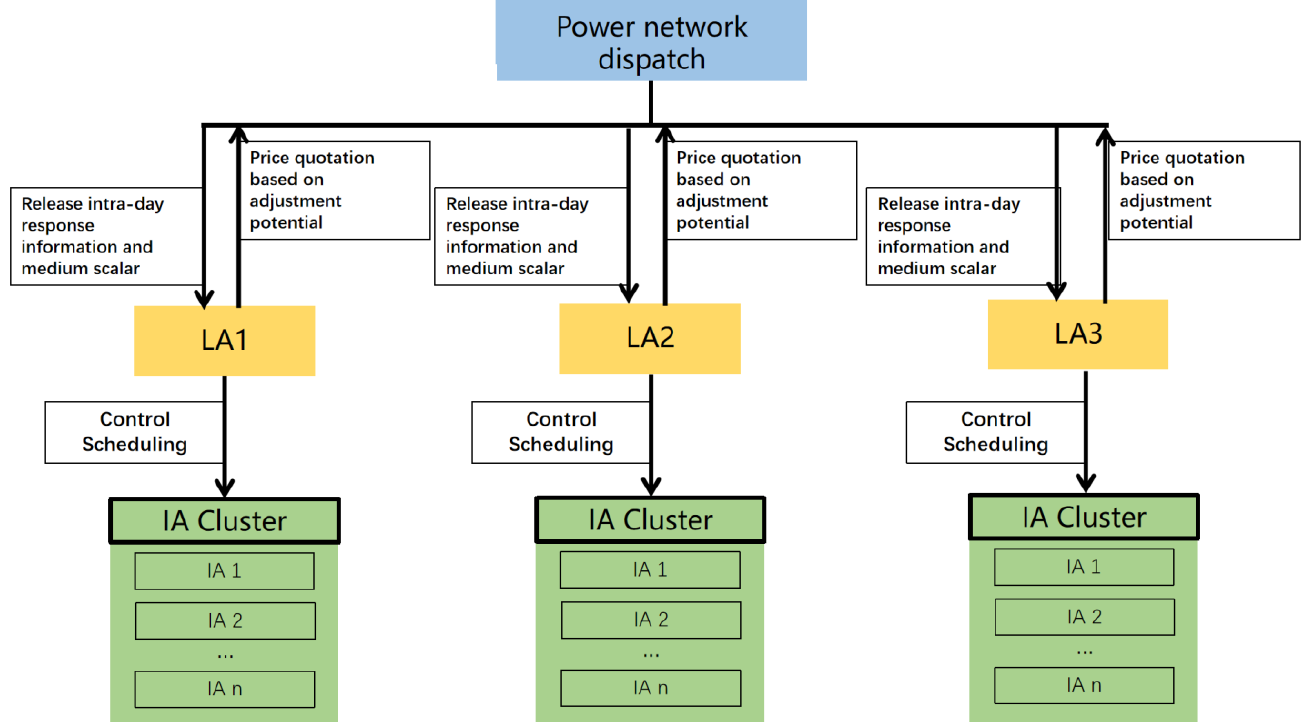
Figure 1. Information interaction in demand response process.